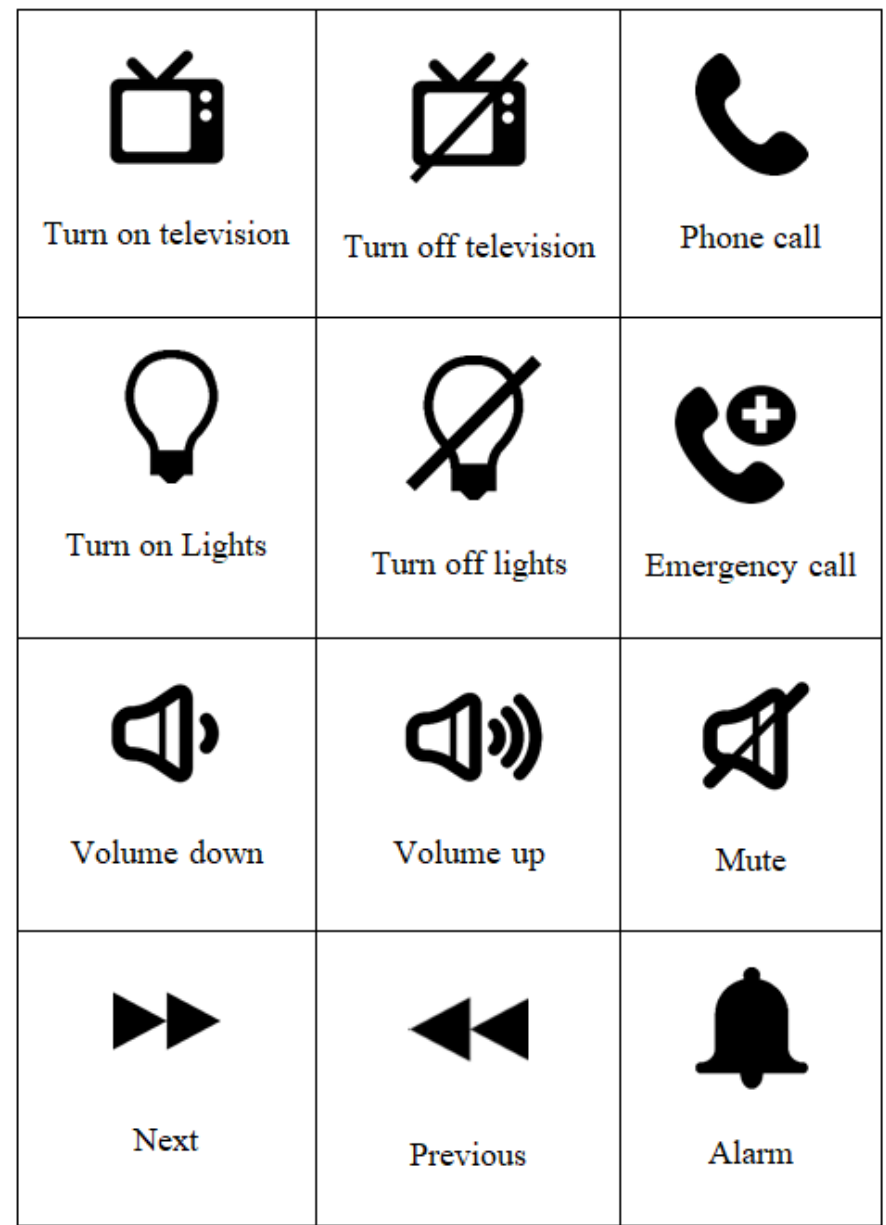
Figure 3. Functional symbols on the main Interface and their description.